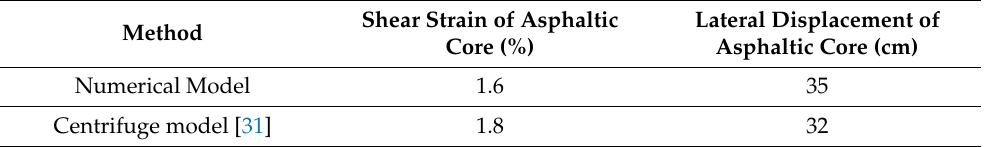
Figure 15. Lateral displacement in the middle of the dam with vertical core. Table 2. Deformation of asphaltic core under dynamic loading.